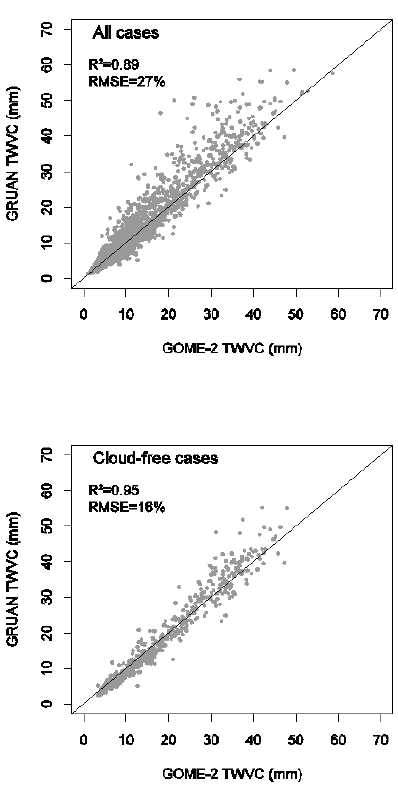
Figure 1. GRUAN TWVC against GOME-2 TWVC data for all- sky conditions (top plot) and cloud-free conditions (bottom plot). The solid line represents the unit slope to which the data comply.